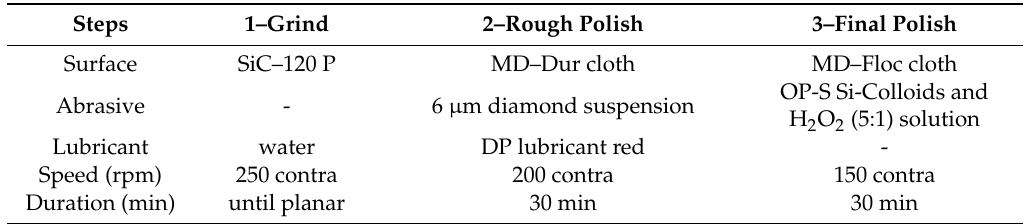
Table 4. The 3-step metallographic preparation of TNTZ-Cu x . All products sourced from Struers, except H 2 O 2 , which was sourced from BASF SE (Ludwigshafen,